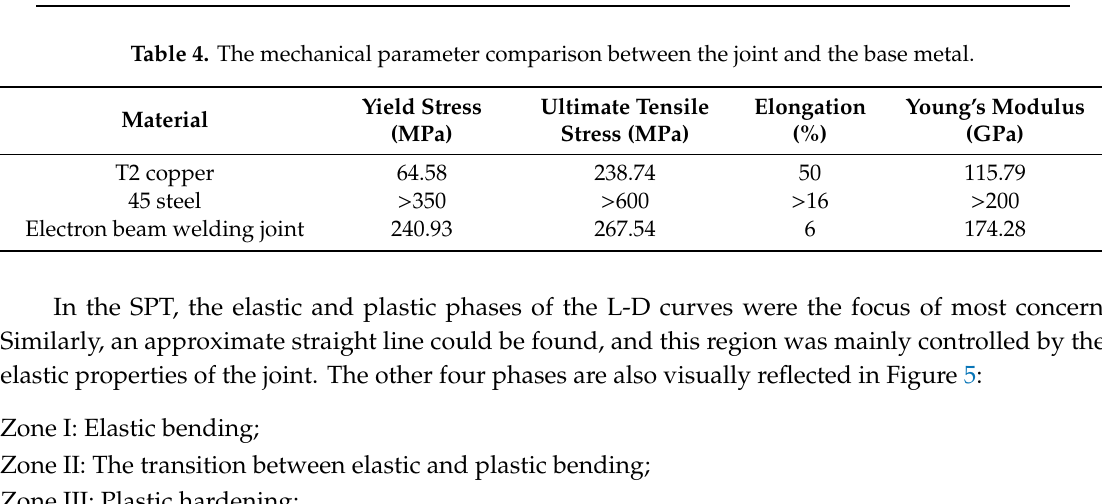
Table 4. The mechanical parameter comparison between the joint and the base metal.